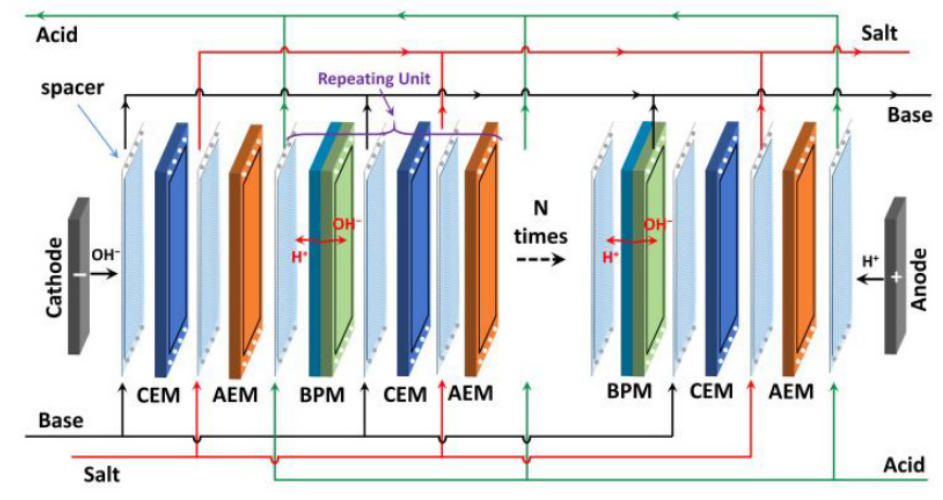
Table 2. Effluent composition.